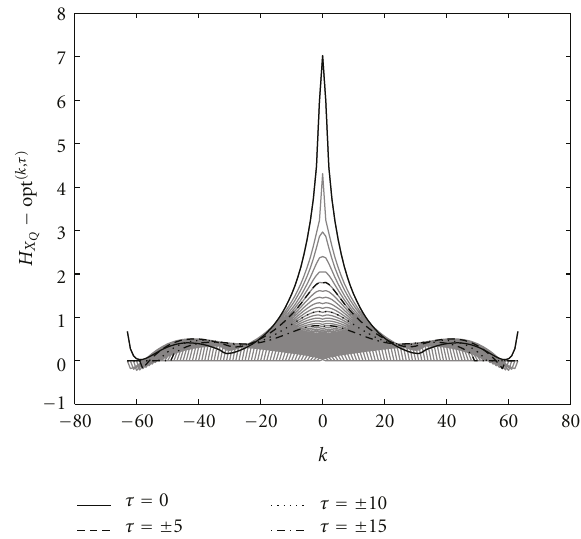
Figure 1: The MSE optimal kernel function for the family of